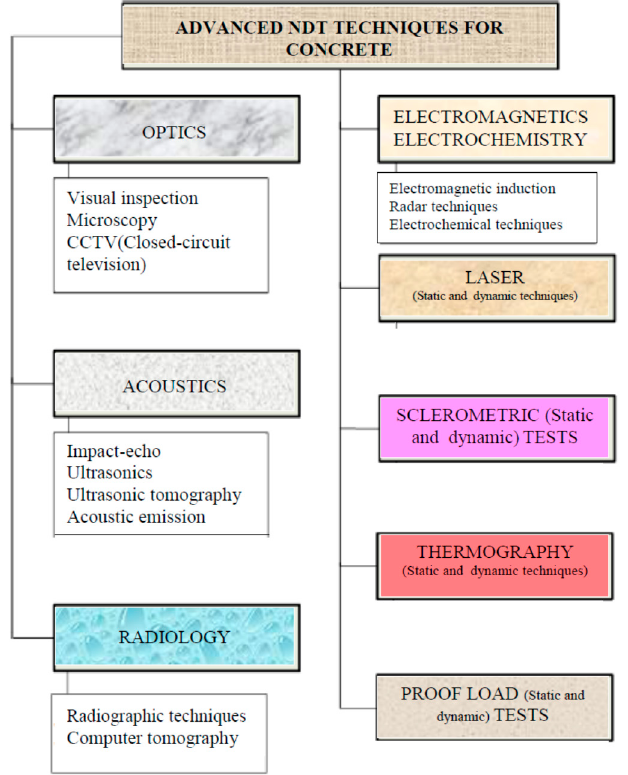
Figure 3. NDT techniques for concrete structures.